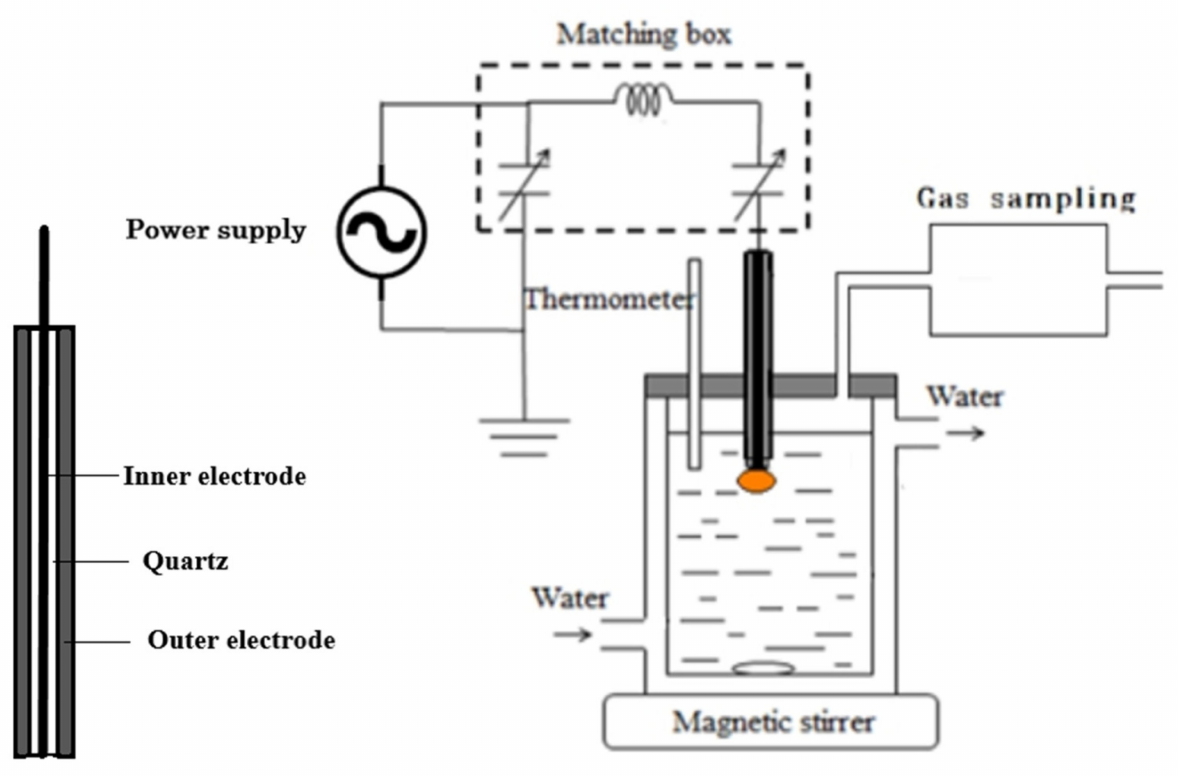
Figure 1. Experimental apparatus for 2,4-D degradation. The reactor was a quartz cylinder with 60 mm of inner diameter and 150 mm in height. The coaxial electrode system consists of an inner electrode (pointed Pt wire, Φ = 1.0